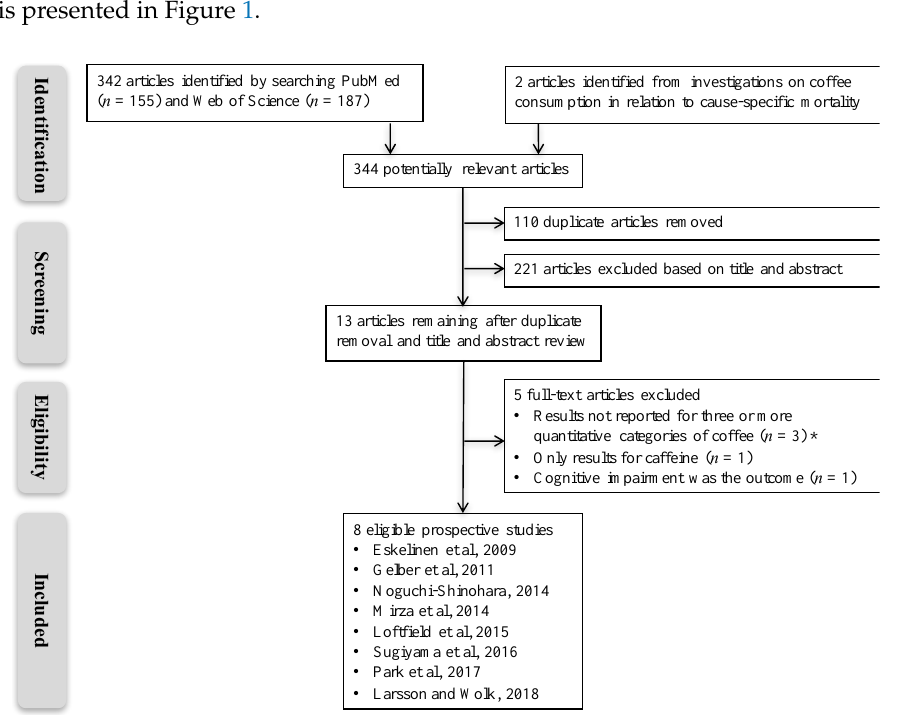
Figure 1. Summary of literature search. * Results reported for regular versus no regular coffee intake [20]; daily versus no daily coffee intake [21]; or per times/week increase in coffee intake